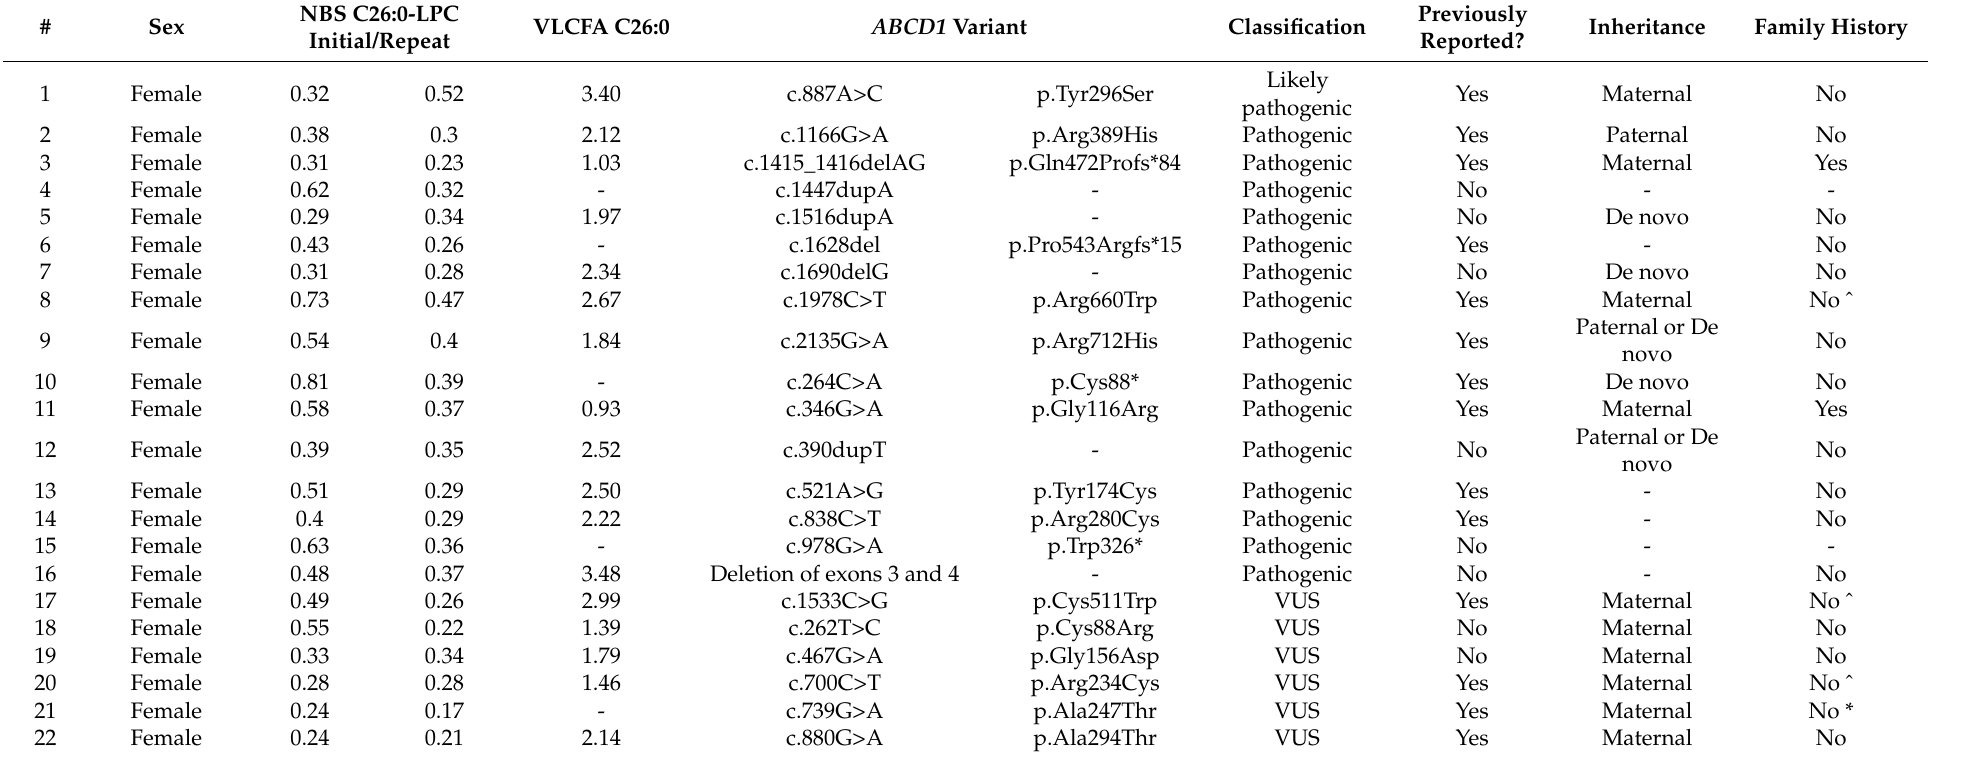
Table 1. Newborn screen, biochemical, and molecular features of 44 Pennsylvanian infants who screened positive for X-ALD between 1 April 2017 and 26 May 2021 and harbored ABCD1 variants. Screening was considered positive for second-tier LC-MS/MS quantitation of C26:0-LPC > 0.15 µ mol/L on initial and repeat dried blood spot specimens. First-tier results from FIA-MS/MS are not shown. Confirmatory biochemical testing with C26:0 quantitation was performed on a clinical basis (reference range: 0.17–0.73 µ mol/L). “-” denotes that the clinical information was unavailable. All units are in µ mol/L. ABCD1 variants and their laboratory interpretation using ACMG criteria are listed. Variants identified in the ALD Variant Database are indicated as previously reported. Inheritance pattern is provided for families in whom parental testing was performed and available. Finally, known family history is denoted for patients in whom there were family members with confirmed, symptomatic X-ALD phenotype. “*” indicates individuals with family members identified via NBS who are known to carry the same variant but are asymptomatic. “ˆ” indicates family individuals whose medical histories were suspicious for symptomatic individuals but for whom an X-ALD diagnosis had not been made (for example: an adult male uncle with progressive gait